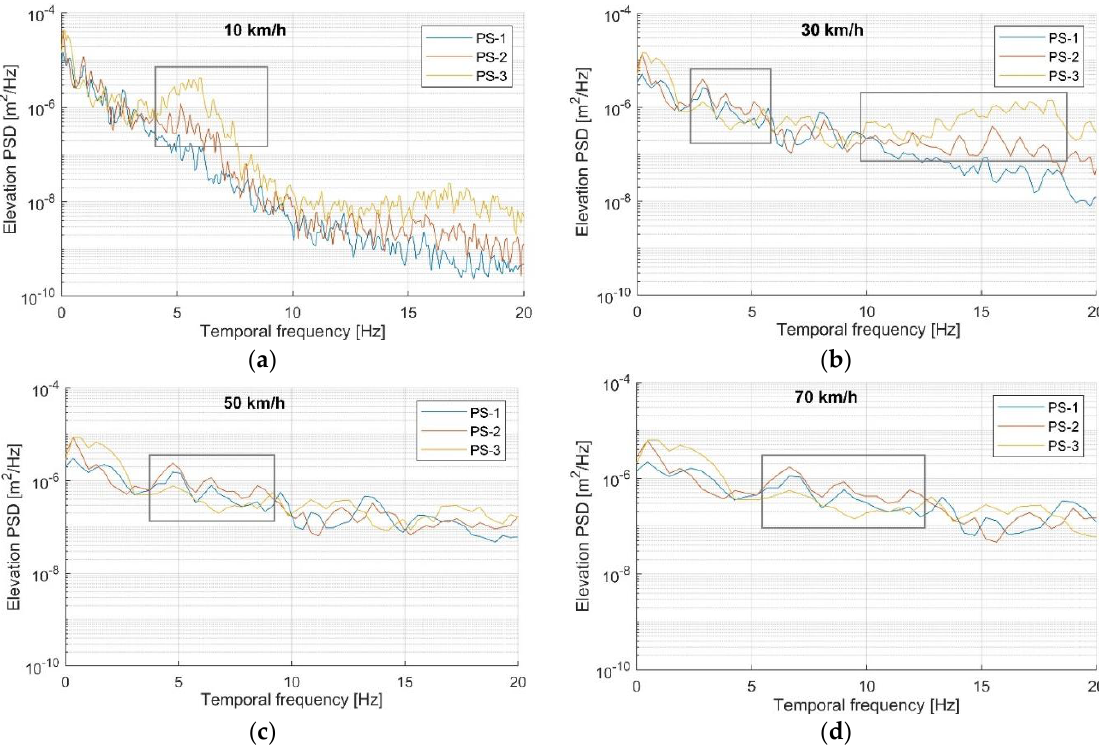
Figure 8. Roughness representation in the temporal frequency: ( a ) 10 km/h; ( b ) 30 km/h; ( c ) 50 km/h; ( d ) 70 km/h.